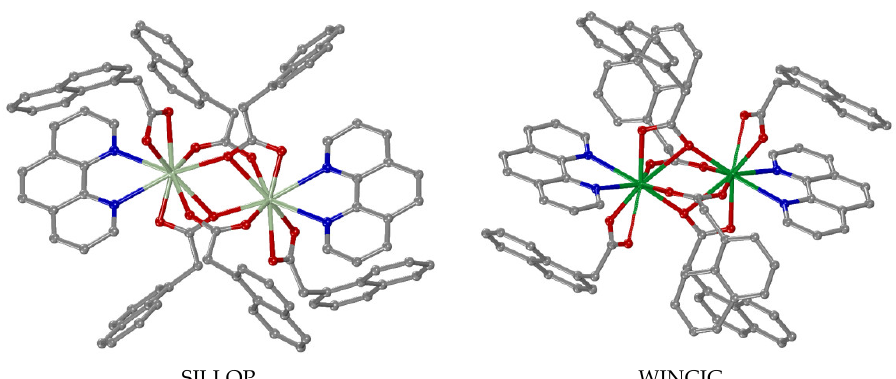
Figure 19. Molecular structures of selected complexes bearing two tridentate bridging (µ–O,O,O′), two bidentate bridging (µ–Ο,Ο’) and two bidentate chelating (κ–O,O′) ligands. SILLOP = [Pr 2 (µ 2 – N1A–O,O,O′) 2 (µ 2 –N1A–O,O′) 2 (κ–N1A–O,O′) 2 (phen) 2 ]·DMF [73] and WINCIG = [Yb 2 (µ 2 –N1A– O,O,O′) 2 (µ 2 –N1A–O,O′) 2 (κ–N1A–O,O′) 2 (phen) 2 ]·DMF [73]. Hydrogen atoms, disordered atoms and solvate molecules are omitted for clarity reasons. Color code for atoms: C: gray, O: red, N: blue, Yb: green and Pr: light green. The figures of the structures were adapted from reference [73].